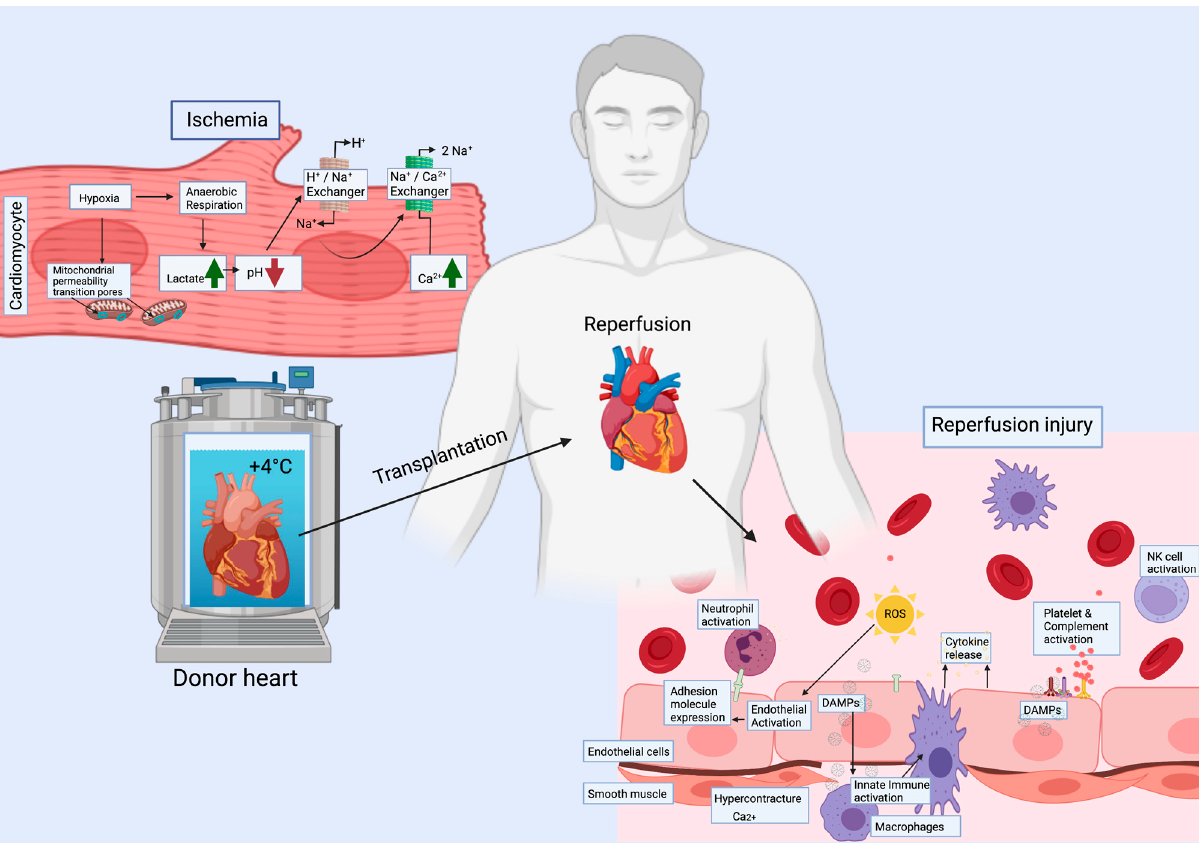
Figure 1. Ischemia and reperfusion induce many cellular changes. During ischemia, all cell types are hypoxic and shift to anaerobic metabolism accompanied with a decrease in pH. As a consequence, the level of Ca 2+ increases. During reperfusion, release of ROS and DAMPs will lead to immune activation with cytokine release, expression of adhesion molecules in endothelial cells and to recruitment of immune cells, as well as platelet and complement activation. The metabolic switch to aerobic accompanied by high intracellular Ca 2+ may cause hypercontracture of the cardiac muscle. ROS = reactive oxygen species, DAMPs = damage associated molecular patterns.